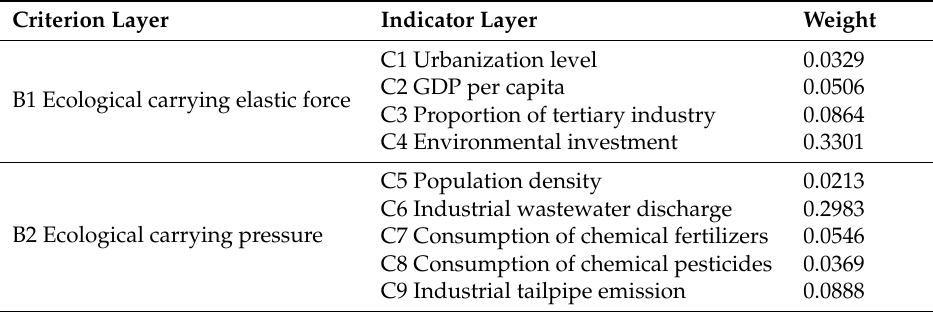
Table 3. Weights of the comprehensive evaluation indices for ecological carrying